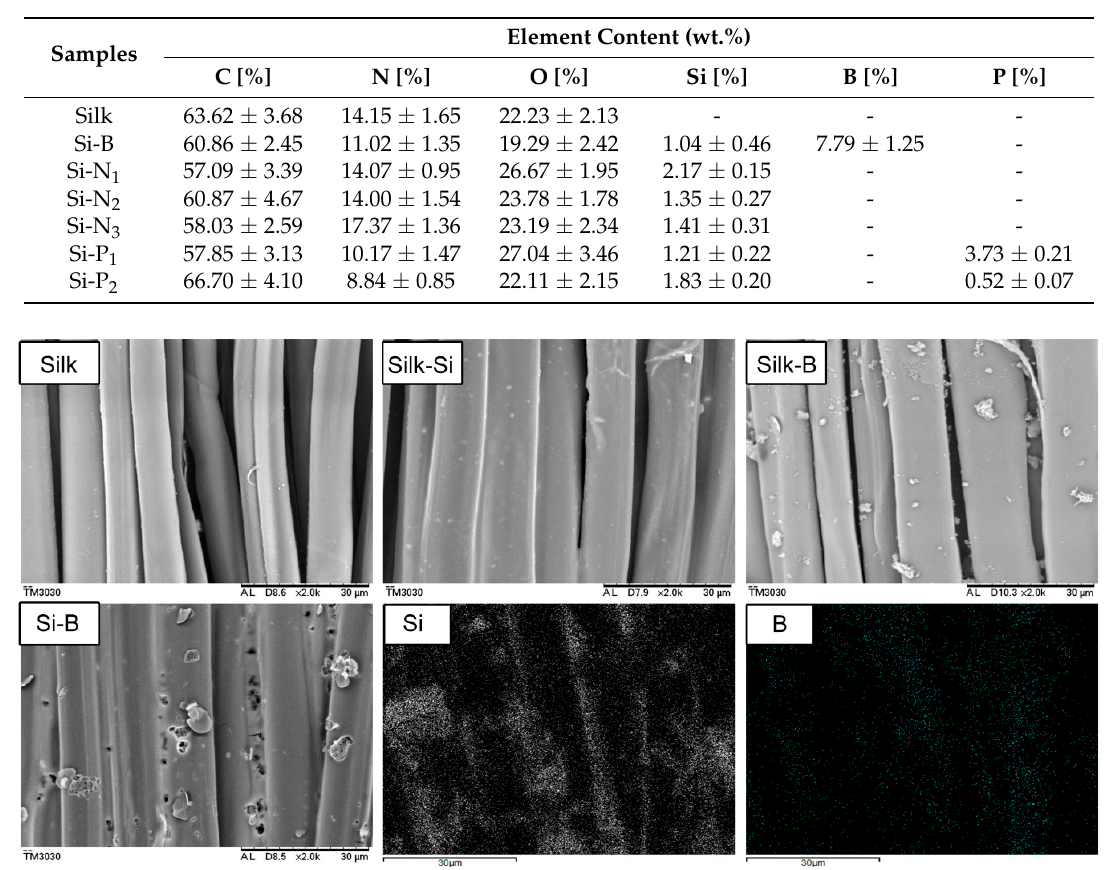
Table 1. Elemental analysis of the pure silk and the treated silk fabrics.